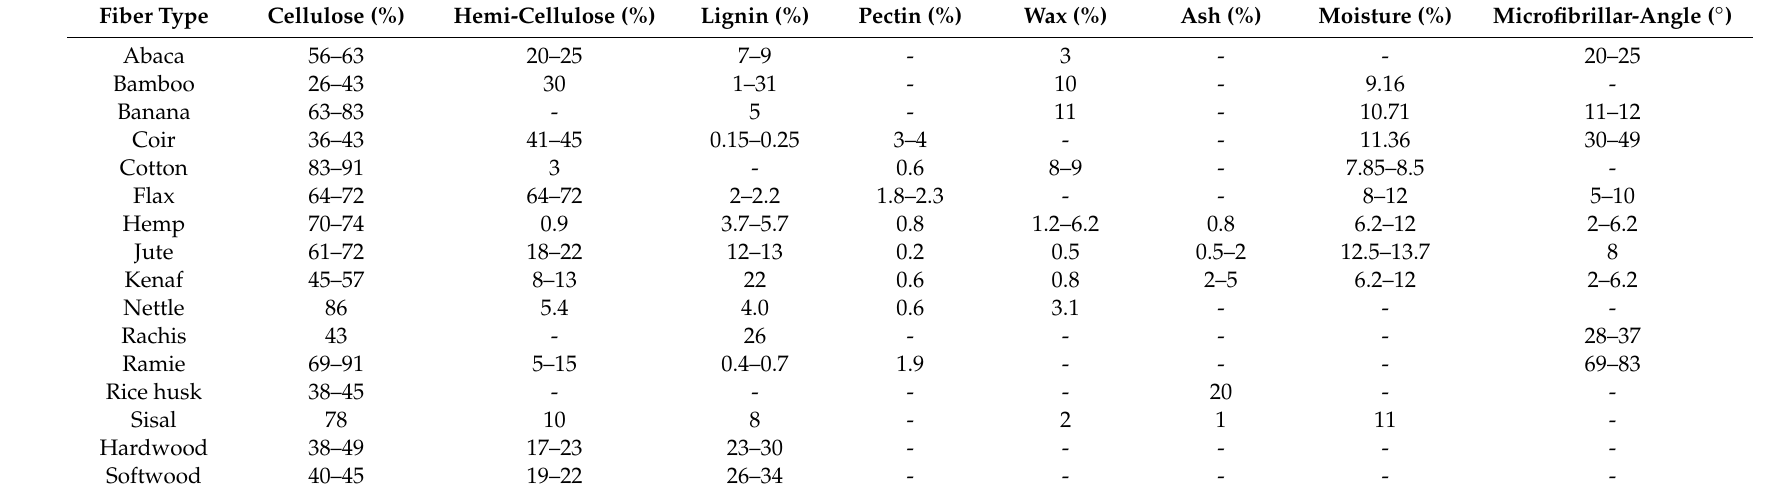
Table 1. Natural fibers chemical composition